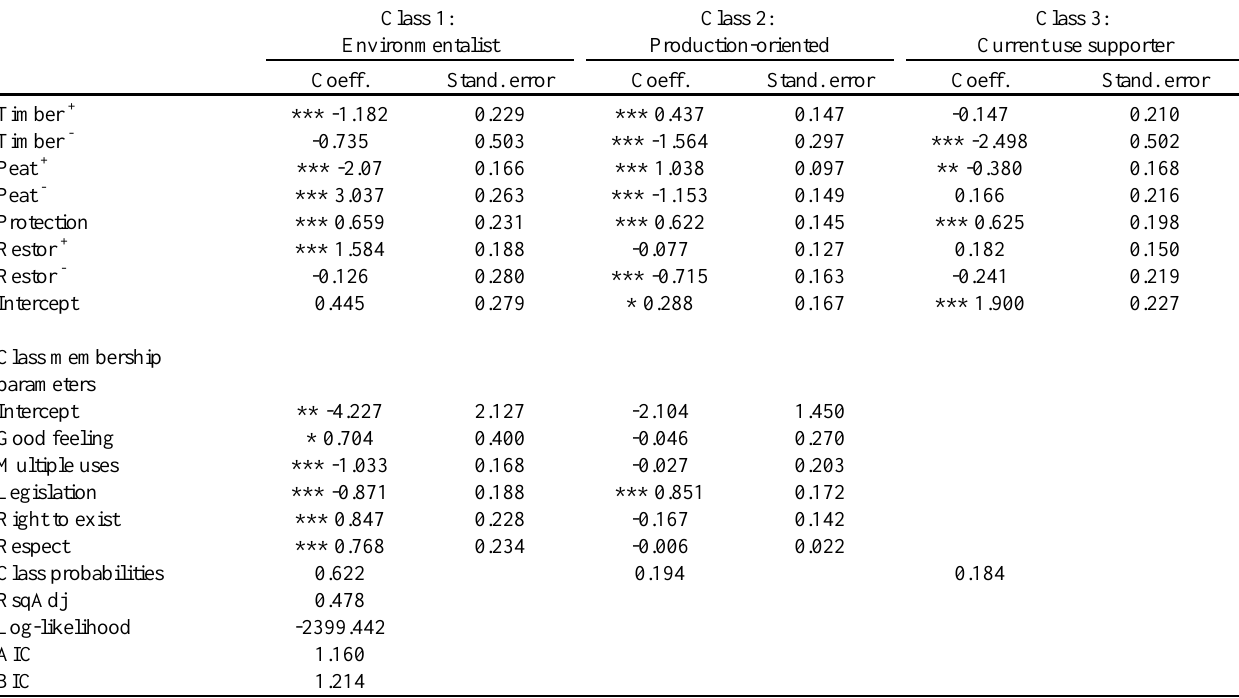
Table 5 . Results of the 3-class latent class model (LCM) including opinions on the significance of nature and peatlands as explanatory variables for class membership. The class membership coefficients for Class 3 were fixed in order to identify the remaining coefficients. Number of respondents =